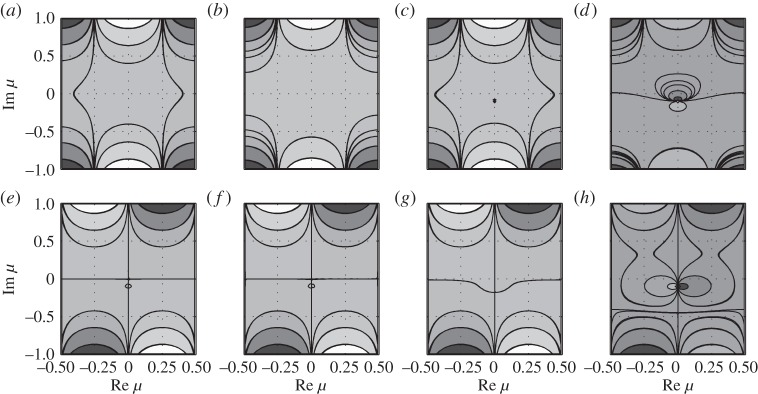
(a–h) Maps of H(μ,0.387,0.1,ψ1,ψ2,δ1,δ2), real part at the top row, imaginary part at the bottom, for four combinations of parameters ψ1, ψ2, δ1 and δ2. From left to right, the combinations are (0.2, 0.2, 0, 0), (0.8, 0.4, 0, 0), (0.2, 0.2, 1, 0.1) and (0.8, 0.4, 1, 0.1). Contour levels are −44, −43, −42, −41, 0, 41, 42, 43 and 44, colour-coded between the darkest and the lightest shades of grey. Equation (B 11), shown by dashed lines, is graphically indistinguishable. The determinant was computed on an 81×81 matrix (its convergence was verified by halving and doubling the size of the matrix); the coefficients in (B 11) were computed based on five points: μ=0 and μ=±0.29±0.29i.